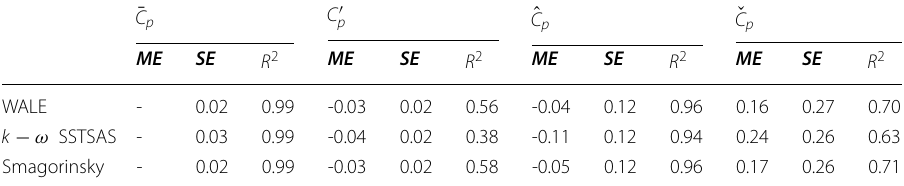
ˇ C , ˆ C p and p for different turbulence models p